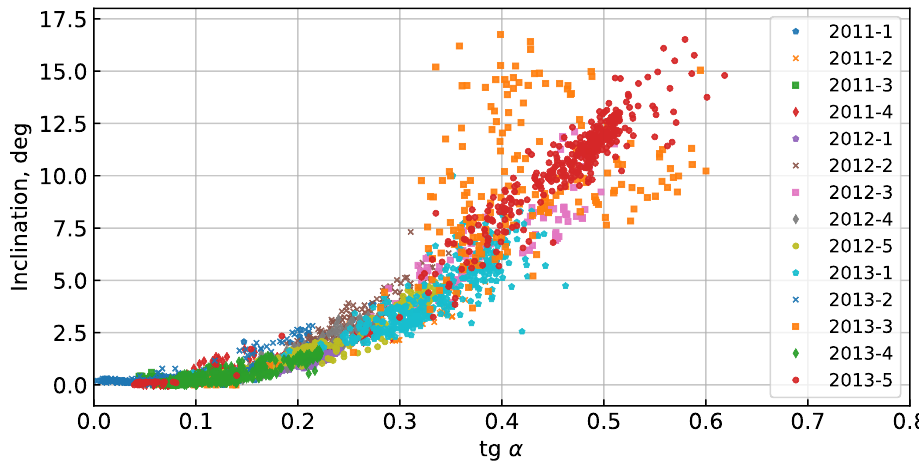
Figure 6. Detector inclination against the detector drift from the start point to the detector altitude ra- tio which roughly translates into the tether inclination angle. See text for details on detector